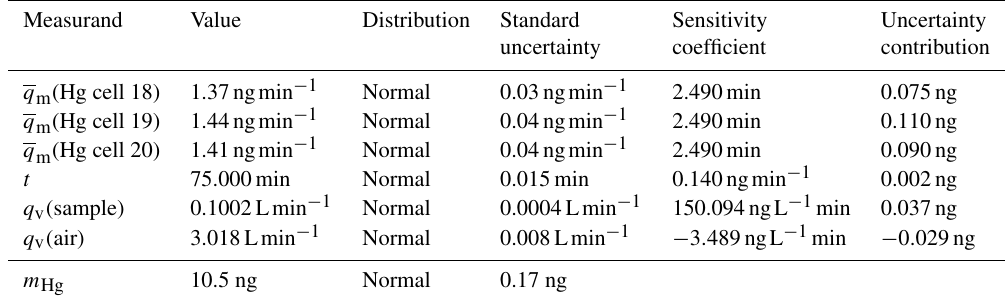
Table 1. Uncertainty budget for mercury amount sampled onto sorbent materials ( k = 1) calculated from Eq. (1) using the law of propagation of uncertainty according to the GUM.